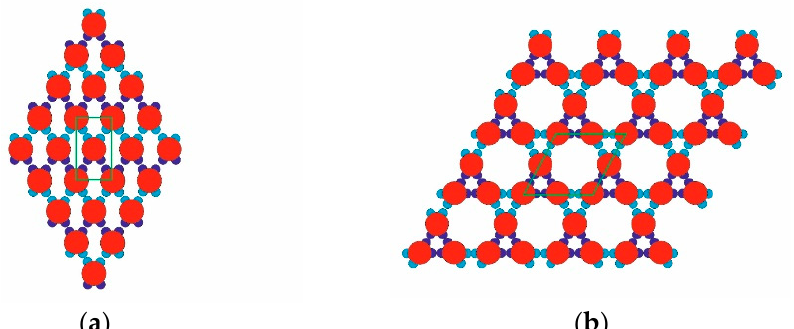
Figure 1. The patchy particle (PP) monomer (red) used in the simulations and the two pairs of patches: strong and narrow (SN; deep blue) and weak and wide (WW; light blue).